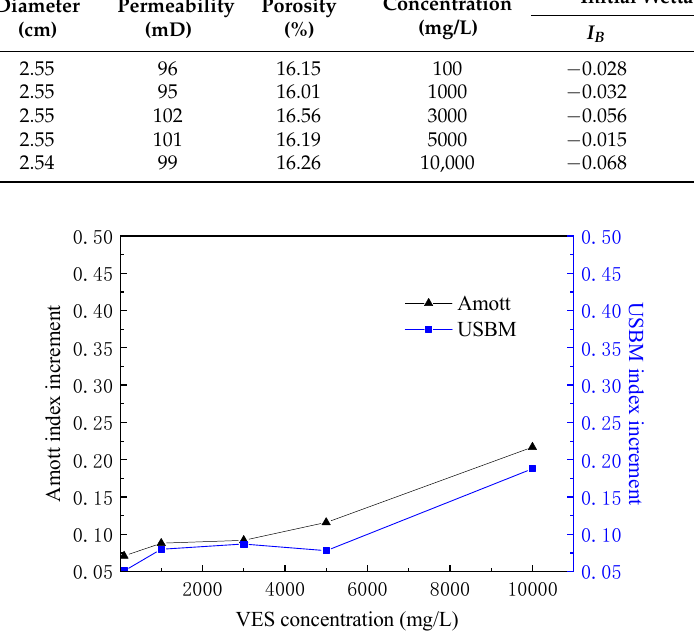
Figure 9. Wettability-index increment vs. VES concentration.